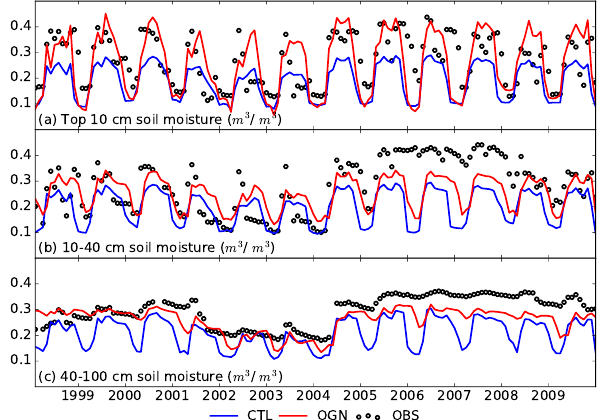
Figure 5. Observed and Noah-MP-simulated monthly soil moisture for BERMS SK-OAS site at a depth of (a) top 10cm, (b) 10–40cm, and (c) 40–100cm.